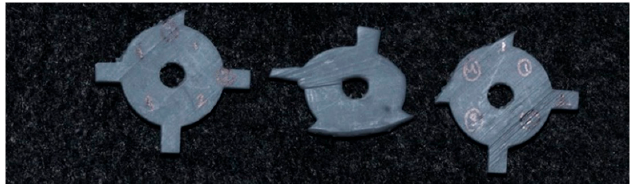
Figure 3. Distorted calibration coupons during the experimental study on the SLA 3D printer. The coupon on the far left shows incomplete printing of the top vertical strut. The middle coupon shows distortion in overall shape and is missing the struts on the right side and on the bottom. The coupon on the far right shows incomplete printing of the vertical struts on the left side and on the top.